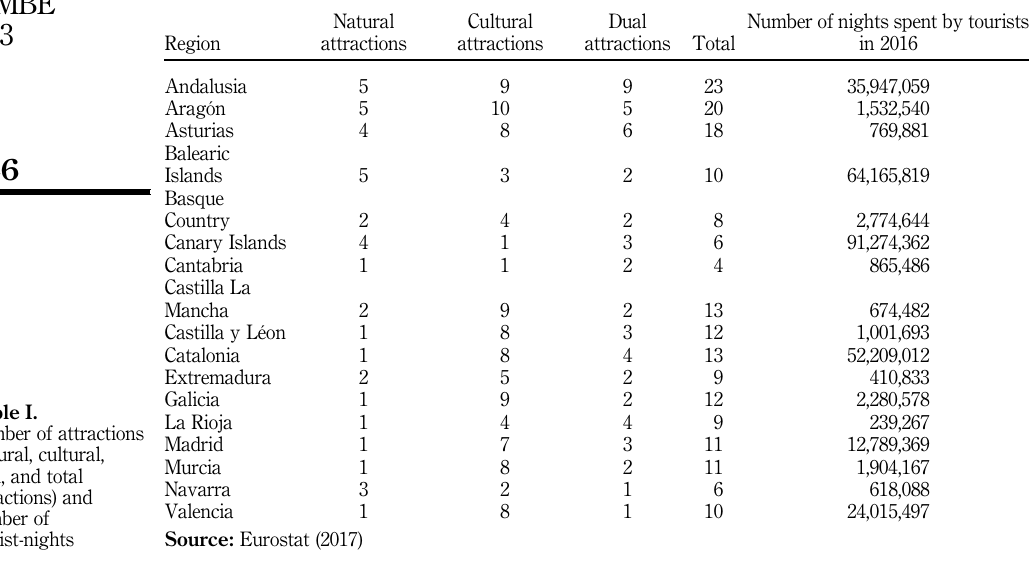
The average number of total tourist attractions in a region was computed at 11.47. Therefore, regions with 11 or less attractions are classified as “ Low Attractions ” regions while the regions with 12 or more attractions were classified as “ High Attraction ” regions. Next, we computed average number of tourist-nights across 17 regions. The average was 17.26 million tourist-nights. Thus, the regions with more than 17.26 million tourist-nights were classified as “ High Tourism ” regions, while the regions with less than 17.26 million tourist-nights were classified as “ Low Tourism ” regions. This two-way (high-low) classification of regions based on number of total attractions and number of tourist-nights resulted in four categories. Table II shows the regions falling under each of the four categories.